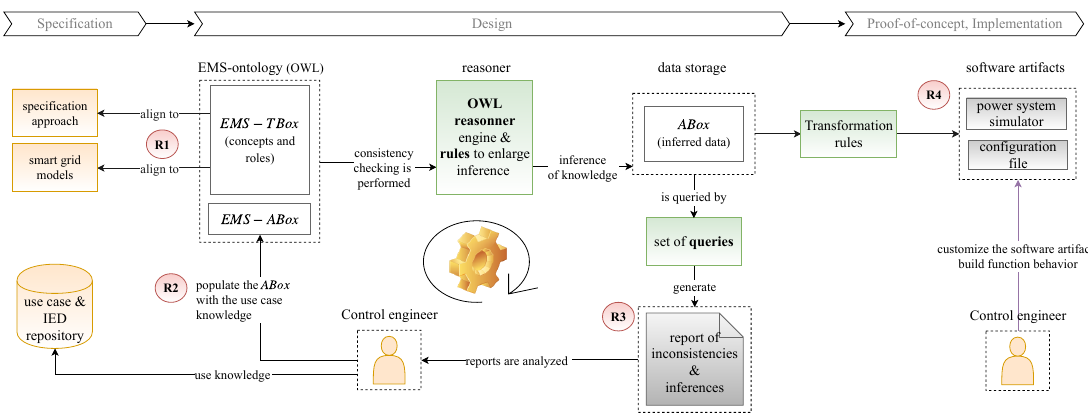
Figure 2. Overview of the EMSOnto framework and corresponding design and engineering